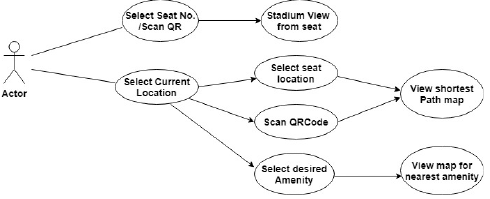
Figure 2. Use Case Diagram.